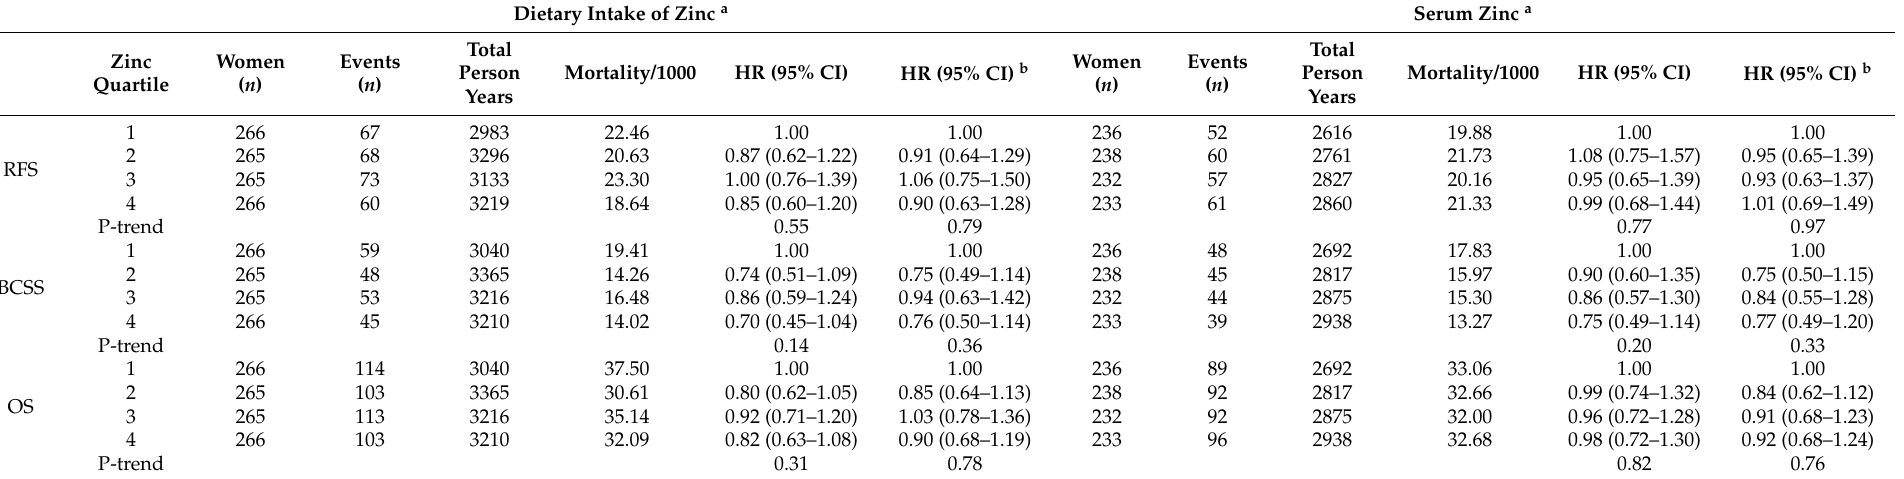
Table 3. Zinc in diet and serum in relation to recurrence-free survival (RFS), breast cancer-specific survival (BCSS) and overall survival (OS). Dietary Intake of Zinc a Serum Zinc